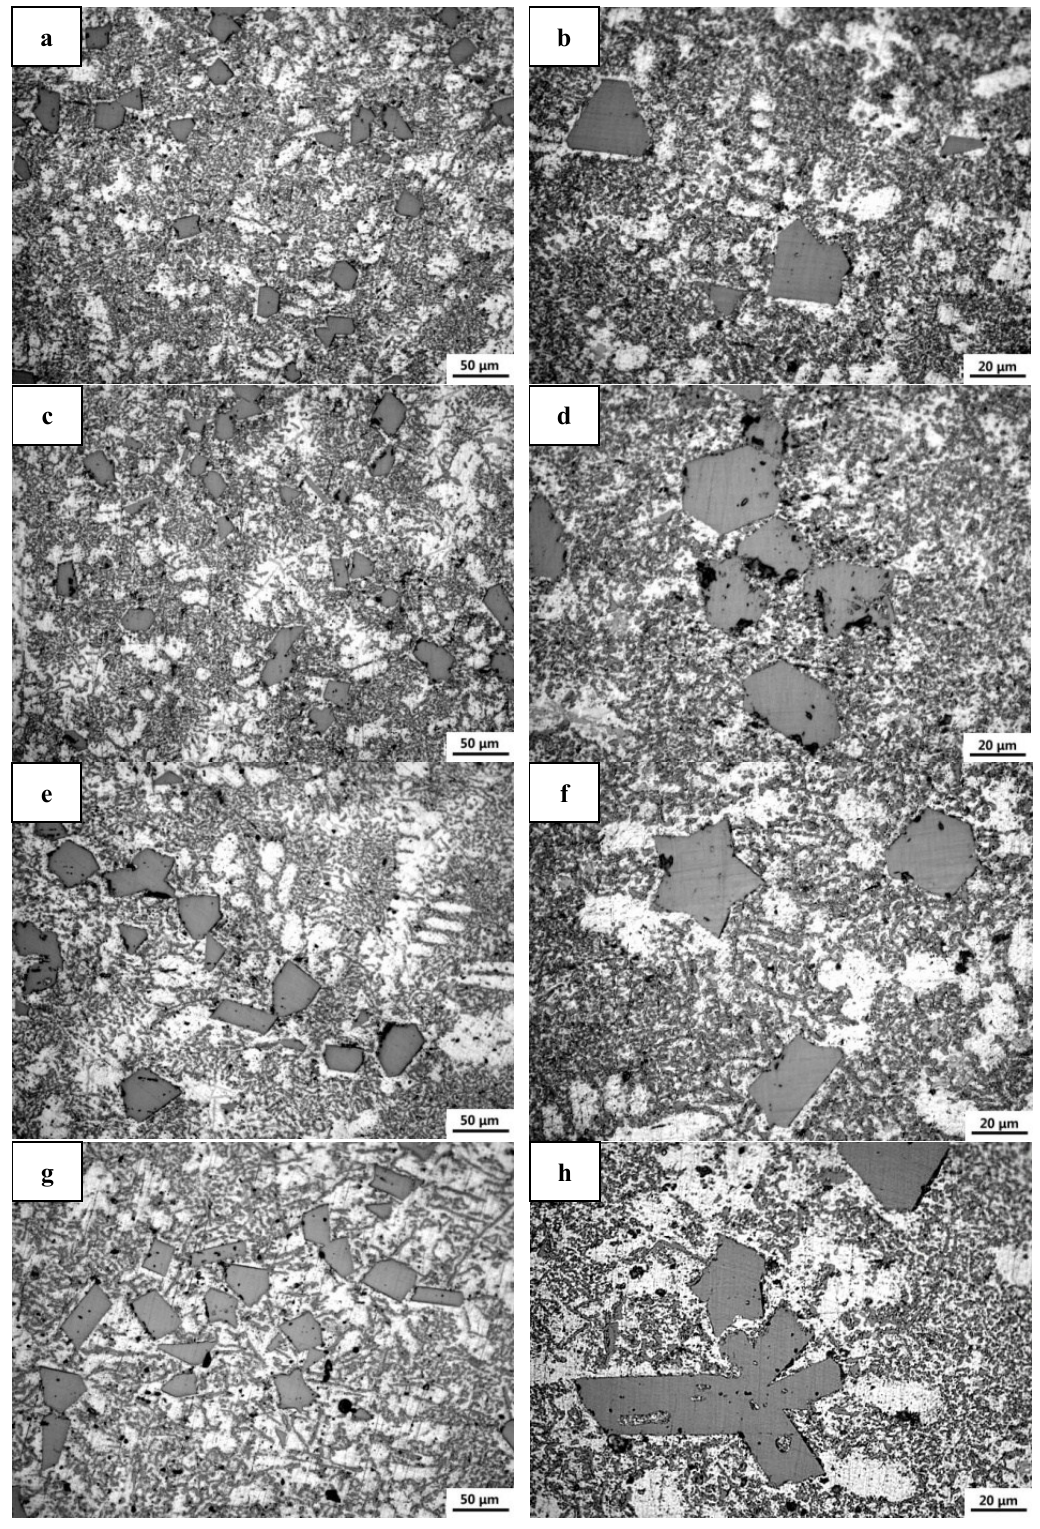
Figure 3. Microstructures of 20% FSM modified Al-17%Si alloy ingots under different holding times: ( a , b ) 15 min; ( c , d ) 35 min; ( e , f ) 60 min; ( g , h ) 95